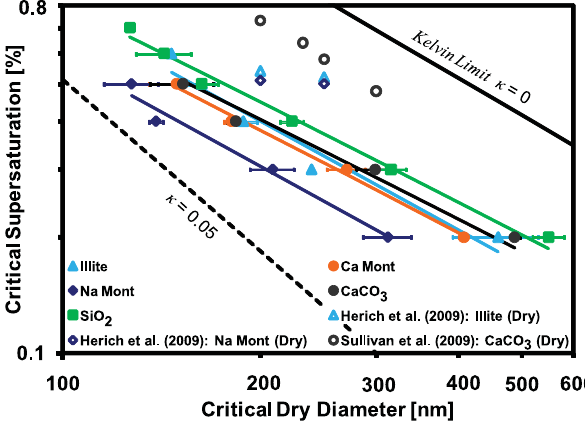
Fig. 6. CCN activation curves for different mineral types presented in Table 1. Symbols (filled) are experimentally determined CCN ac- tivity, and lines represent FHH adsorption activation fits. Open sym- bols represent data obtained from Sullivan et al., 2009, and Herich et al., 2009. Color scheme of open symbols identical to CCN activ- ity observed with measurements in this study. Error bars represent measurement uncertainty in D dry . Also shown in black thick line is the κ = 0, Kelvin curve. Black dashed line corresponds to κ = 0 .